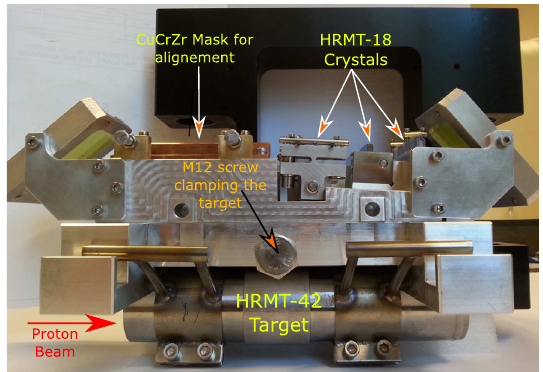
FIG. 7. Pressure response at the center of core rods No. 2, No. 4, No. 7 and No. 10 when impacted by the HiRadMat beam, estimated by hydrocode simulations using the software AUTODYN ®